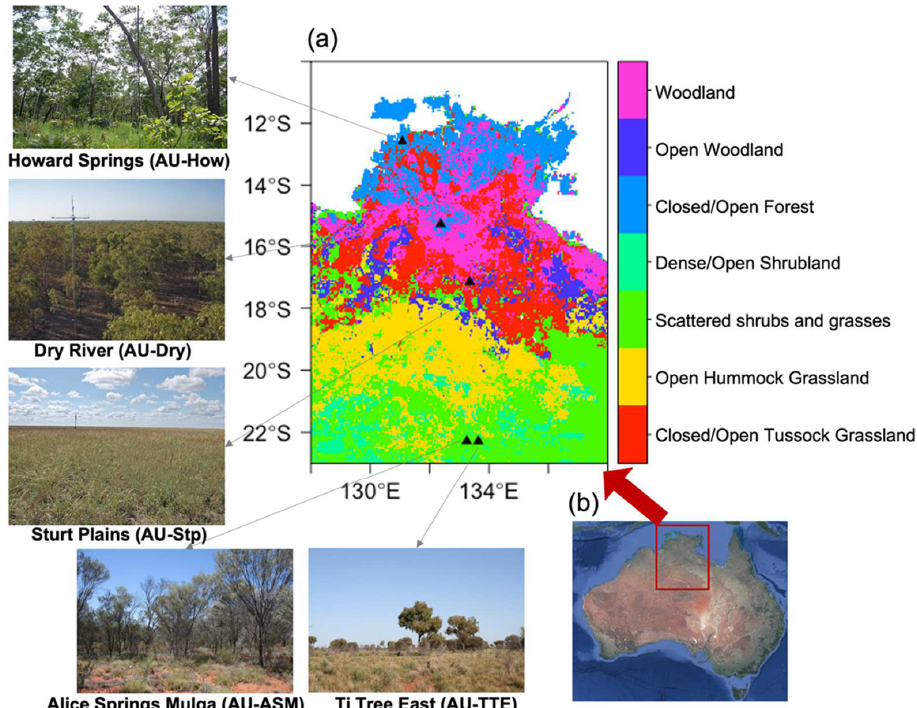
Figure 1. ( a ) Land cover map of the Northern Australian Tropical Transect (NATT) study area (data source: Dynamic Land Cover Dataset). Black triangles refer to the five flux tower sites. Photographs show the ground-view of each flux tower site linked with the black arrow (image source: www.ozflux.org.au, accessed on 1 October 2020). ( b ) The locations of the study area over the Australian continent (image source: Google Earth).